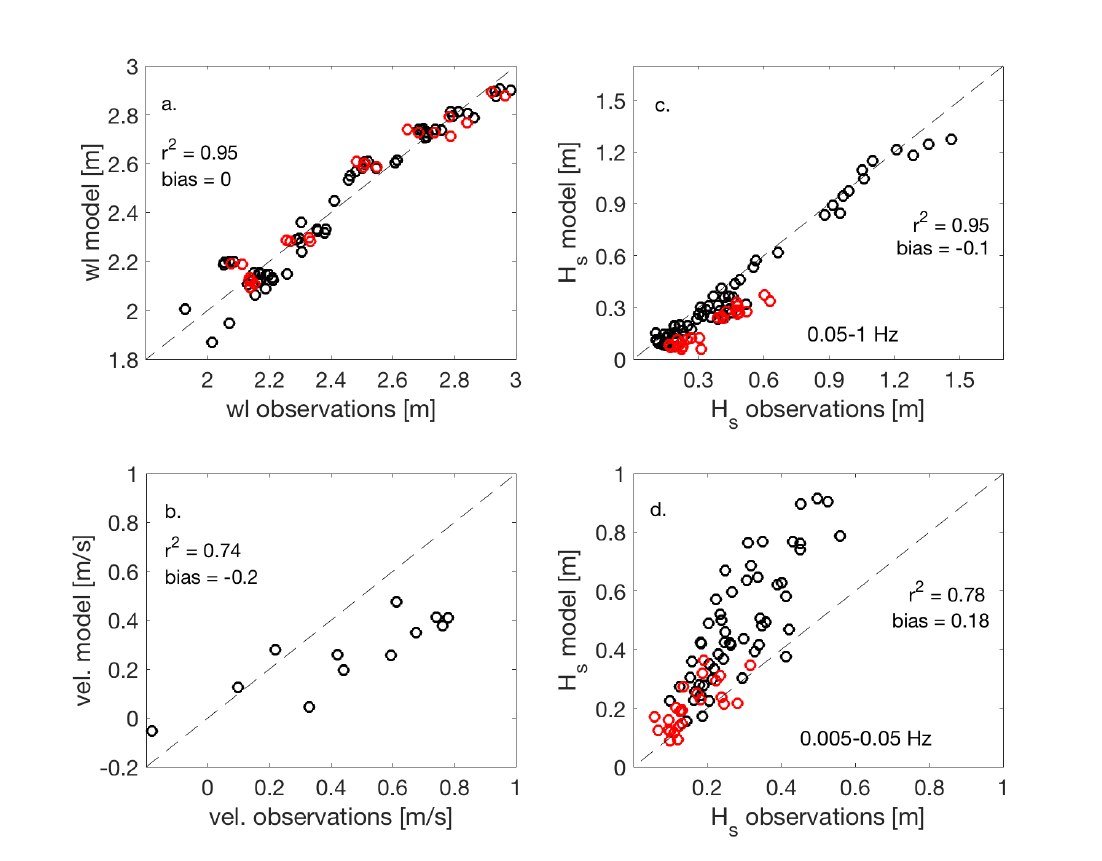
Figure A2. Observed and modeled water levels (wl, a ), cross-shore velocities (vel, b ), and short- ( c ) and IG ( d ) significant wave heights ( H s ) for all 4 floodings from 1 h before until 1 h after high tide (hourly output). The red circles indicate measurements at P5 and P6, the instruments closest to the Wadden